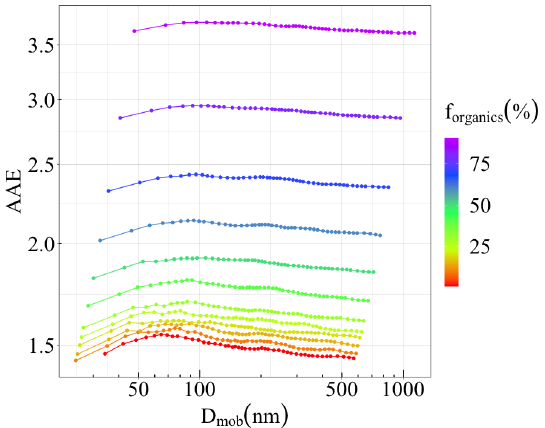
Figure 11. Ångström absorption exponent (AAE) of coated BCFAs ( D f = 1.7) with changing fraction of organics ( f organics ) and mobil- ity diameter ( D mob ).